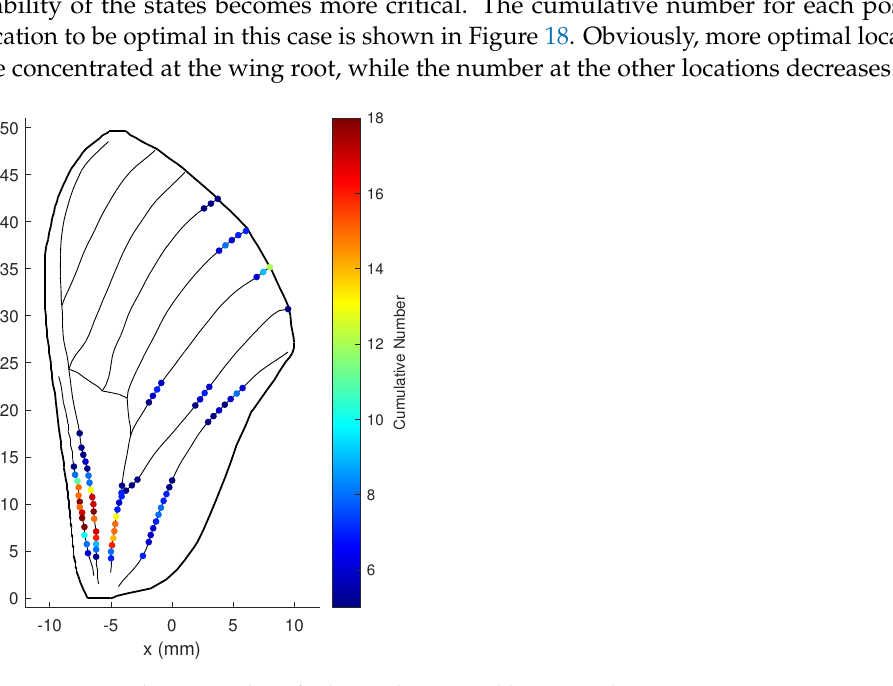
Figure 18. Cumulative numbers for being the optimal location when measurement noise variance is large: ω (cid:118) = 1, ω Υ = 100, and r = 20. With r = 30 the numbers for all three groups are increased, as illustrated in Figure 19.